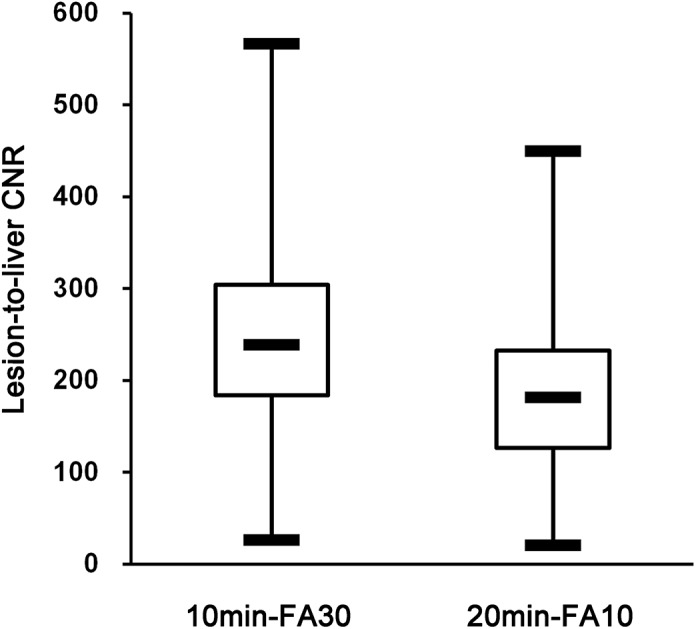
Lesion-to-liver contrast-to-noise ratio (CNR).Box-and-whisker plots showing the median (middle line of each box), quartiles (top and bottom lines of each box), and upper and lower adjacent (upper and lower whiskers for each box) values of the lesion-to-liver contrast-to-noise ratio (CNR). Liver metastases were imaged according to two different protocols: 10 minute delayed hepatocyte phase imaging with a 30° flip angle (10min-FA30) and 20 minute delayed hepatocyte phase imaging with a 10° flip angle (20min-FA10). The mean CNR for FHLs imaged with the 10min-FA30 protocol was significantly higher than that of FHLs imaged with the 20min-FA10 protocol.